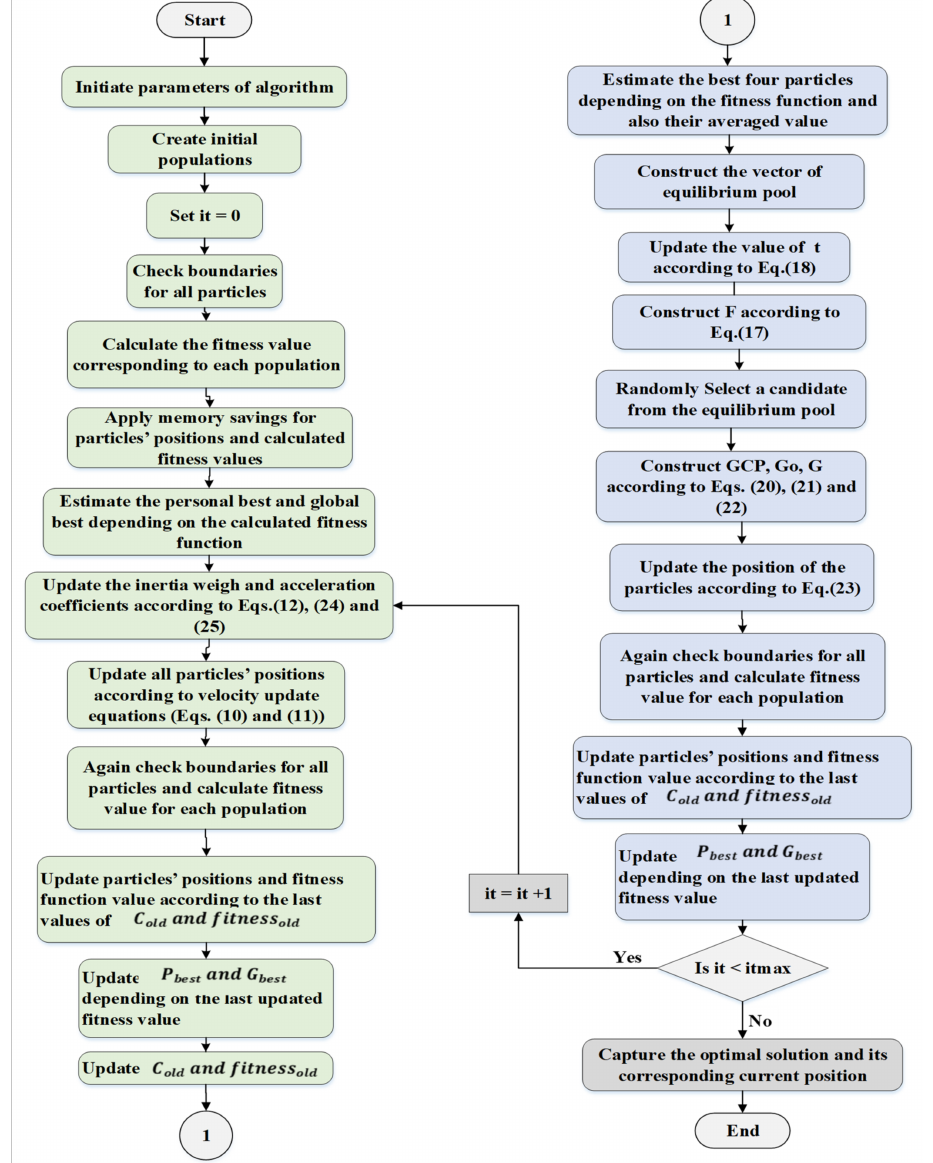
Figure 1. Flow chart of proposed